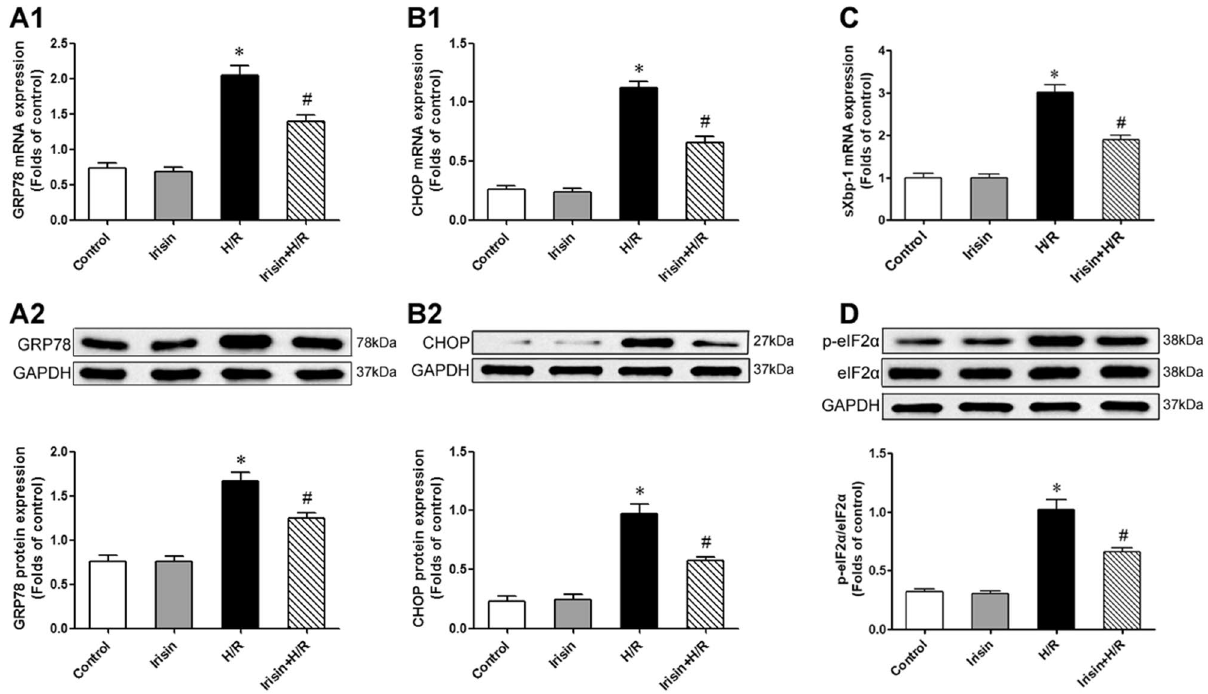
Figure 4. H/R treatment resulted in excessive ER stress and CHOP upregulation. The GRP78, CHOP, sXbp- 1, and eIF2α expressions were assessed by PCR or Western blot analysis. ( A ) Effects of irisin on H/R induced GRP78 mRNA ( A1 ) and protein ( A2 ) expression. ( B ) Effects of irisin on H/R induced CHOP mRNA ( B1 ) and protein ( B2 ) expression. ( C ) Effects of irisin on H/R induced sXbp-1 mRNA expression. ( D ) Effects of irisin on H/R induced eIF2α phosphorylation. *P < 0.05 versus control group, # P < 0.05 versus H/R group, n =